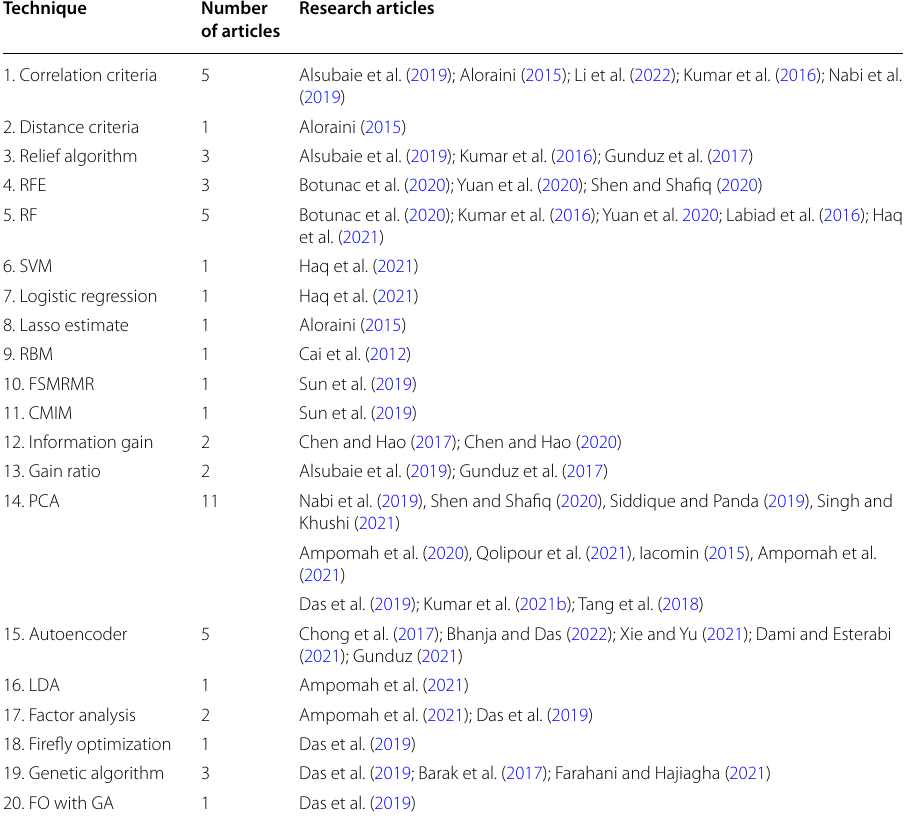
Table 3 Feature selection/extraction techniques applied in the reviewed articles Technique Number Research of articles